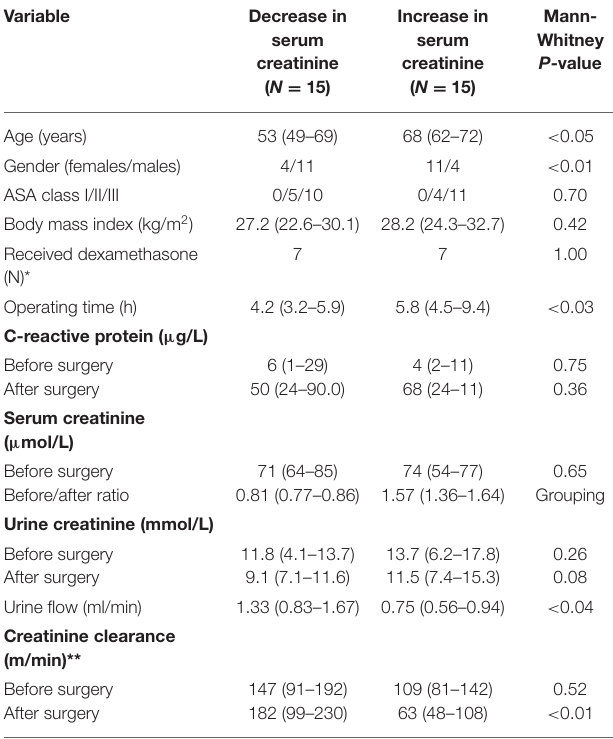
TABLE 1 | Demographic data and measurements of creatinine in the serum and urine before surgery and on the first morning after the surgery.